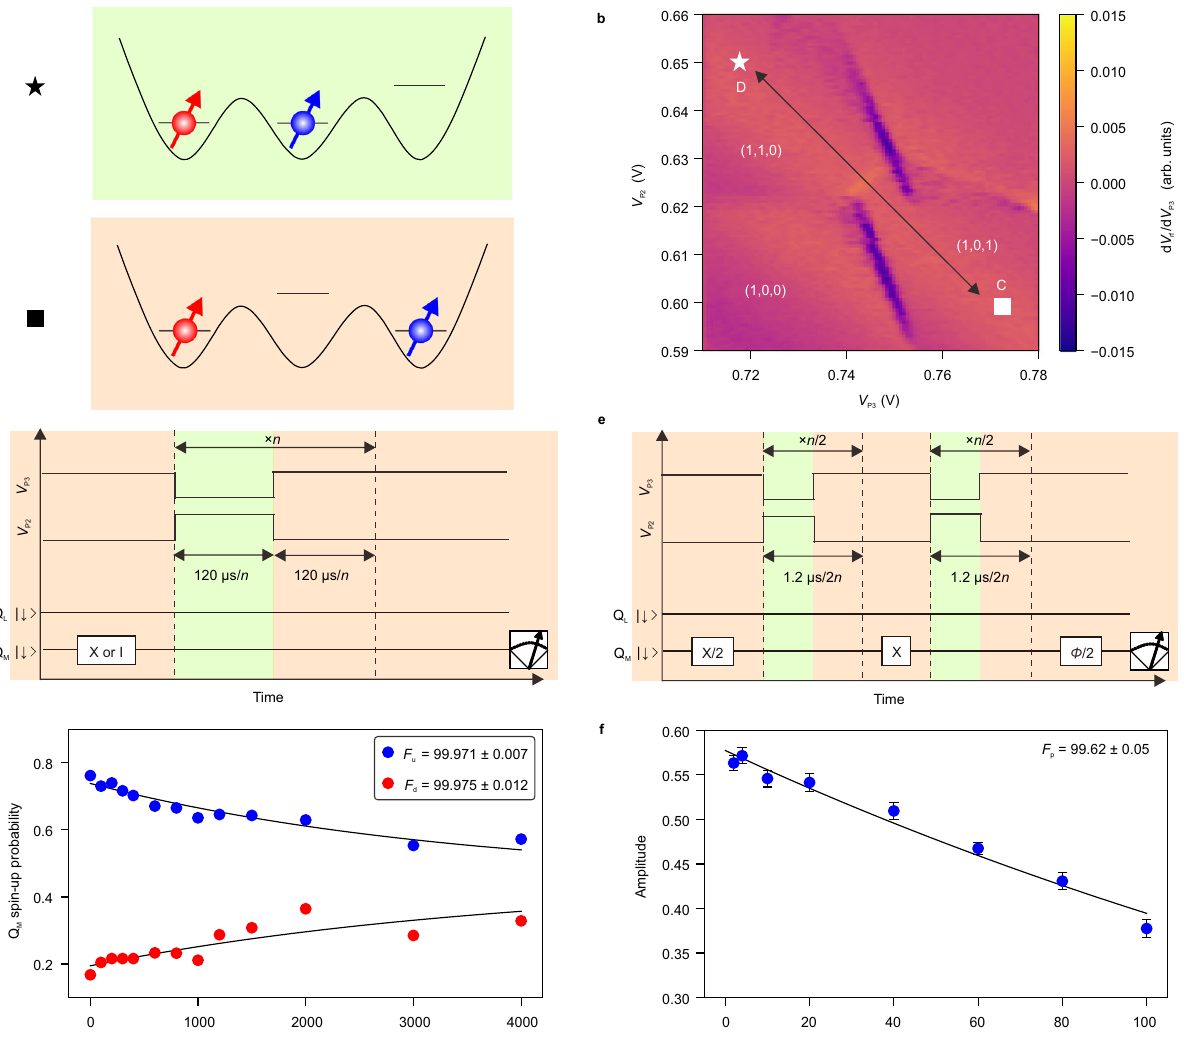
Fig. 2 | Performance of coherent shuttling of Q M . a Energy diagram of the triple quantum dot at the gate voltage condition shown in the white symbols in ( b ). b Charge stability diagram around the (1,0,1) (sparse state) and (1,1,0) (coupled state) charge states. c Pulse sequence used to measure the spin-up probability depending on the number of shuttling cycles n shown in ( d ). We use the charge symmetry-point at the coupled state. To eliminate the spin relaxation effect dependingontime,thetotaltimespentateachdotis fi xedat120 µ sindependentof n . d Spin-up probability after repeated shuttling cycles. We extract fi delities of the spin polarization preservation during a single back and forth shuttling cycle as F d (prepared in spin-down) and F u (prepared in spin-up) from fi tting the data with an